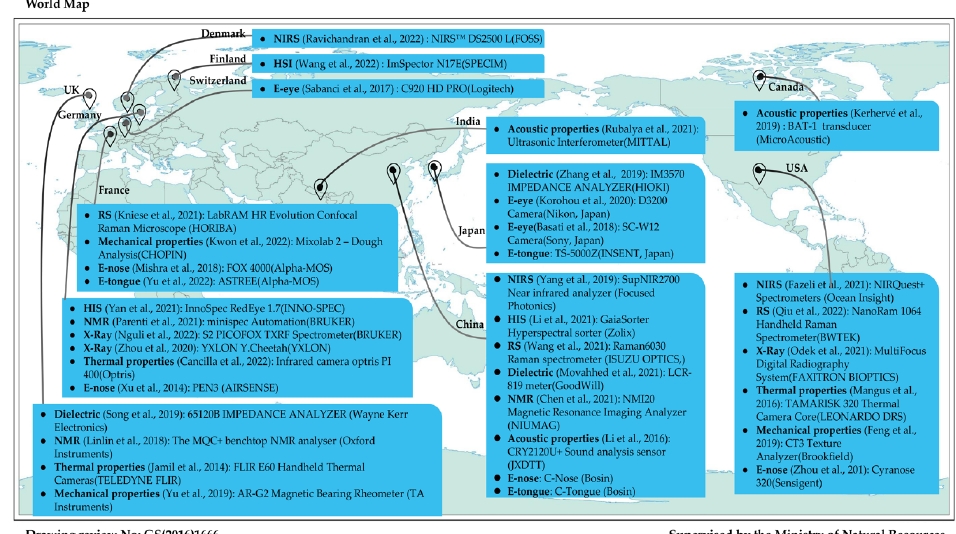
Figure 2. Commercial instruments for grain quality detection